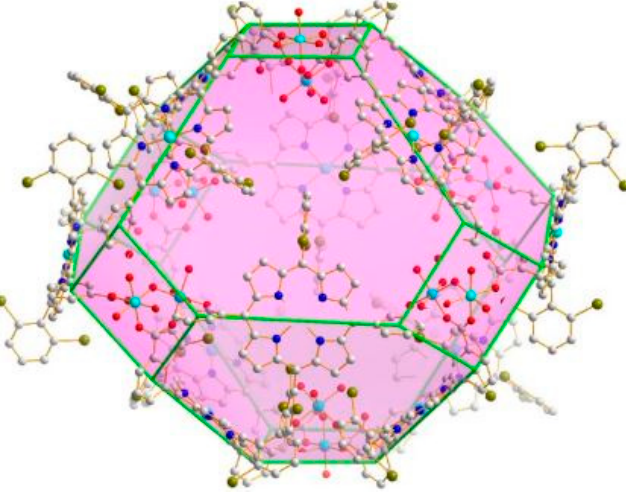
Figure 6. Schematic representation of the truncated octahedron polyhedral cages present in MMPF-3.